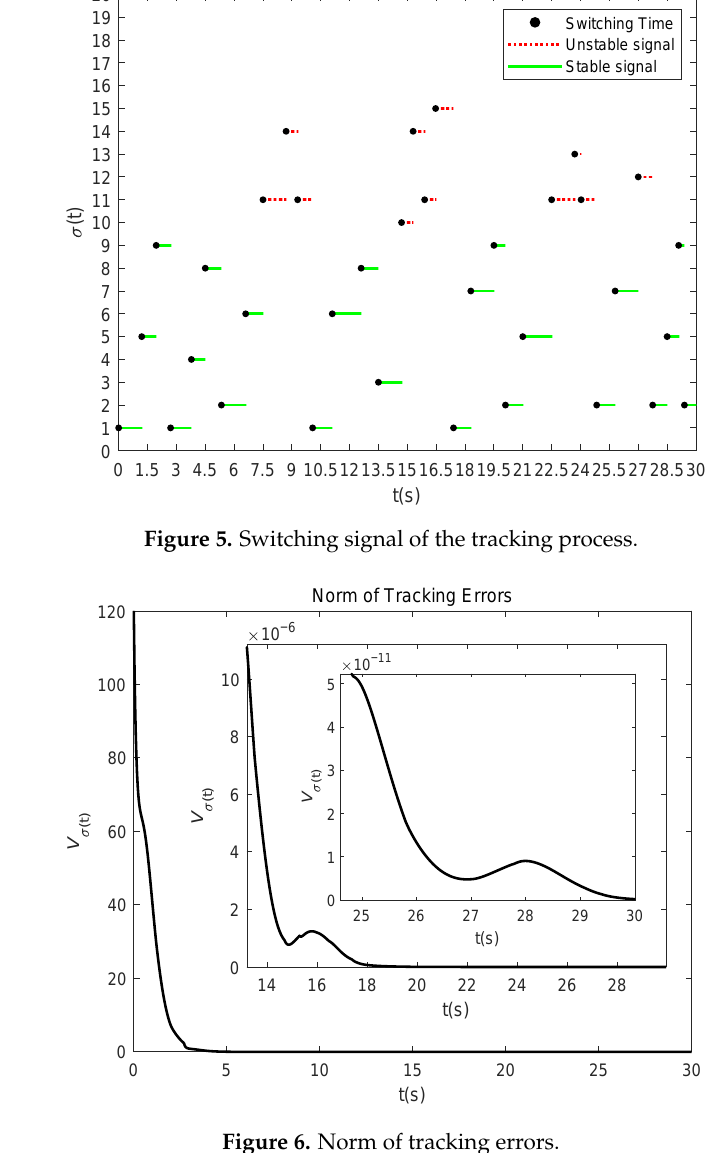
Figure 6. Norm of tracking